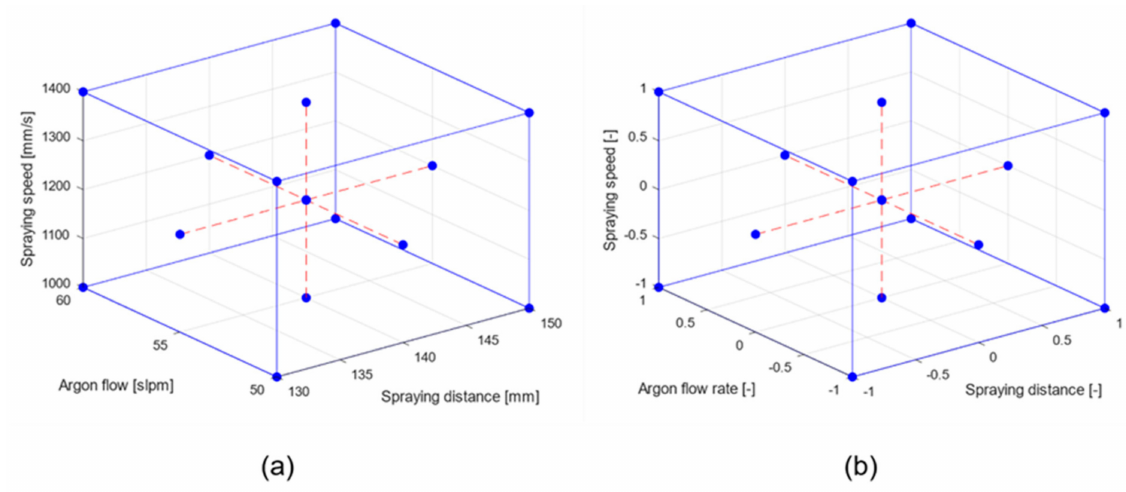
Figure 4. Central composite design for 3 factors with faced points and considering ( a ) real units X or ( b ) codified units x